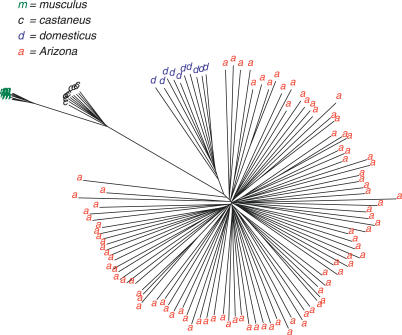
A Neighbor-Joining Tree of Wild-Caught House Mice Based on Allele-Sharing at 4158 SNP LociThe individuals include ten M. m. domesticus from Western Europe, seven M. m. musculus from Eastern Europe, nine M. m. castaneus from India, and 94 mice from Tucson, Arizona. The Arizona mice appear closely related to domesticus from Western Europe, as expected from the history of North American colonization and other evidence [1]. The small terminal branch lengths of musculus and castaneus may be due to an ascertainment bias in the SNPs, which were discovered in laboratory strains in which the nuclear genome seems to be predominantly of domesticus origin [4,56].